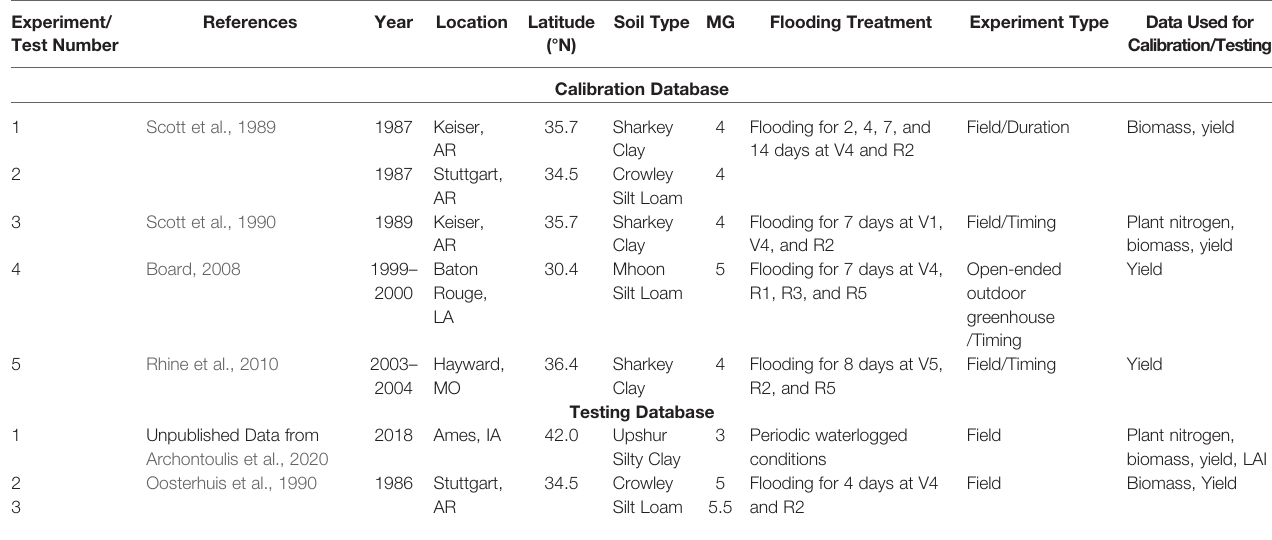
TABLE 1 | Overview of the published studies used in this modeling study. Experiment/ Test